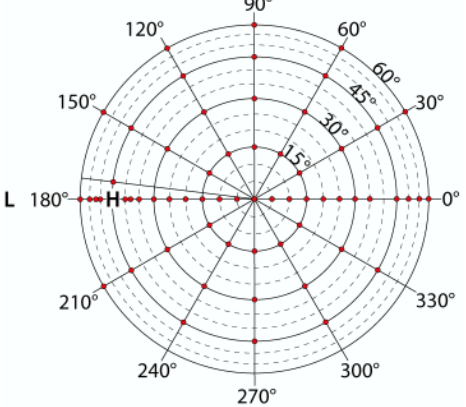
Figure 3. Measurement positions with an illumination zenith angle of 45°. L is the position of the light source and H is the hot-spot.